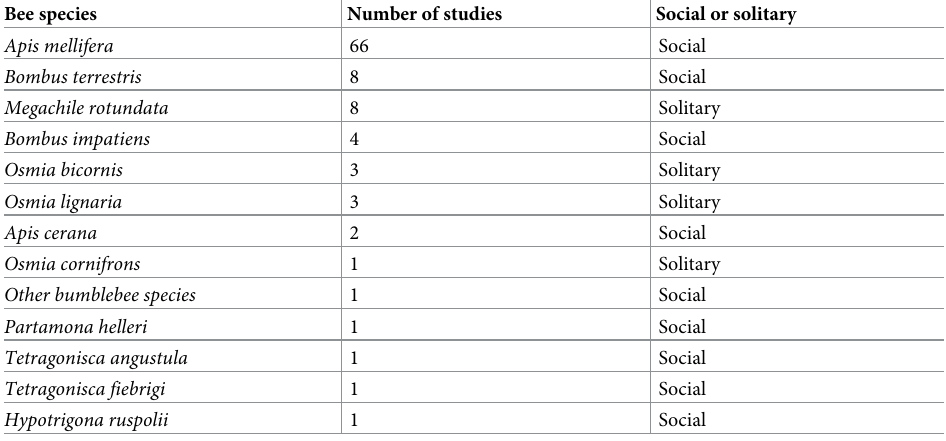
Table 2. The numbers of studies investigating the effects of herbicides and/or fungicides on different bee species. Bee